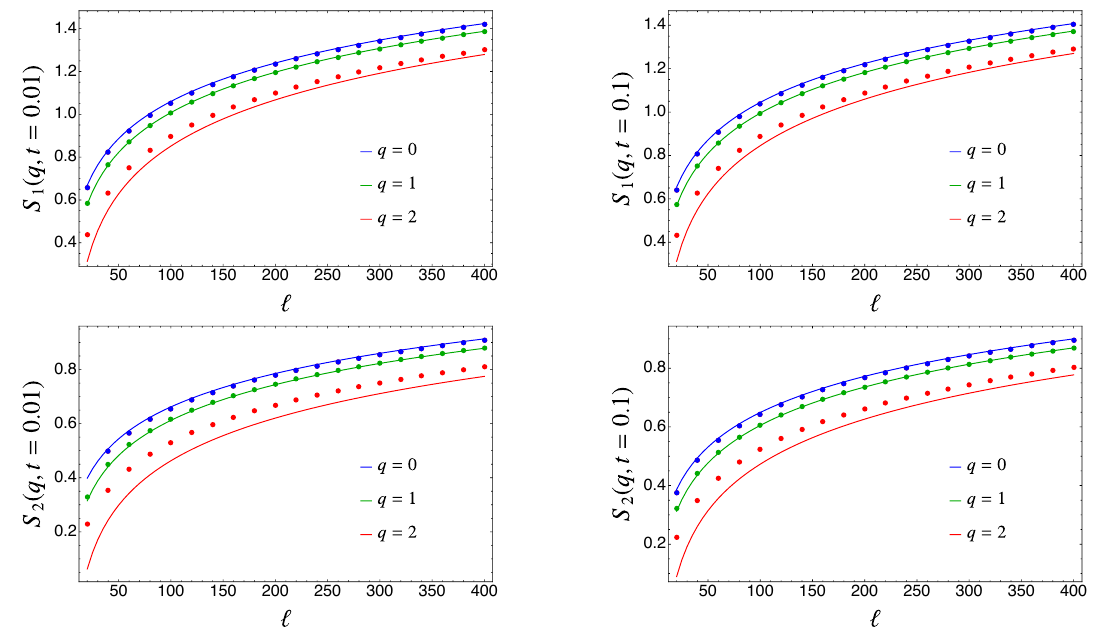
Figure 5 . Symmetry resolved entanglement entropies for a few di(cid:11)erent values of q and n as func- tions of ‘ . The (cid:12)eld theory prediction is tested against exact lattice computations. The agreement with eq. (4.24), that includes lattice e(cid:11)ects, is remarkable. For large j q j , the approximation at the order q 2 is no longer su(cid:14)cient and neglected corrections to the scaling become important, as well known for the massless case